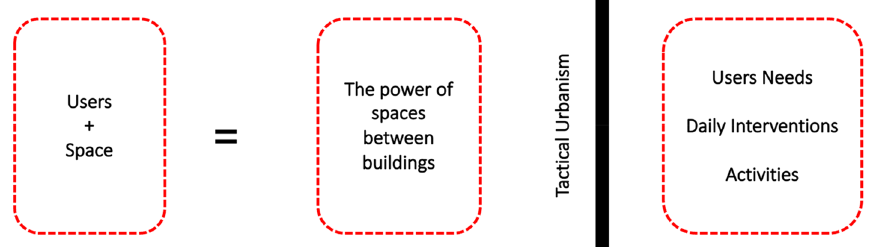
Fig. 2 Revitalisation frameworks for spaces between